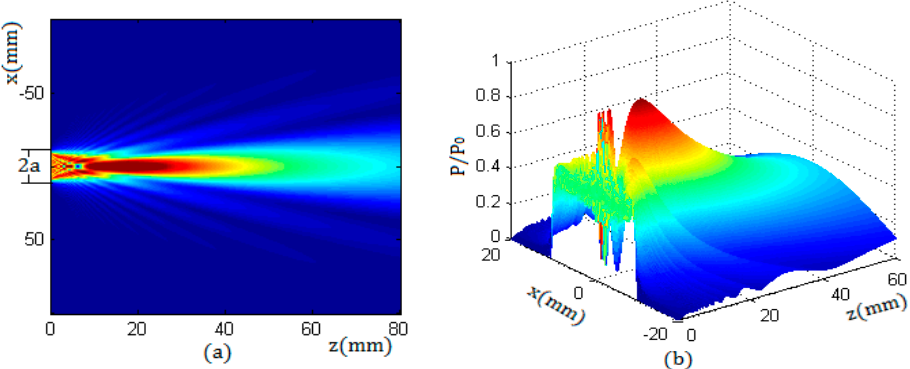
Figure 3. The sound pressure distribution of a round piston transducer in aluminum; ( a ) the 2D distribution in the XOZ plane; and ( b ) the 3D distribution in the YOZ